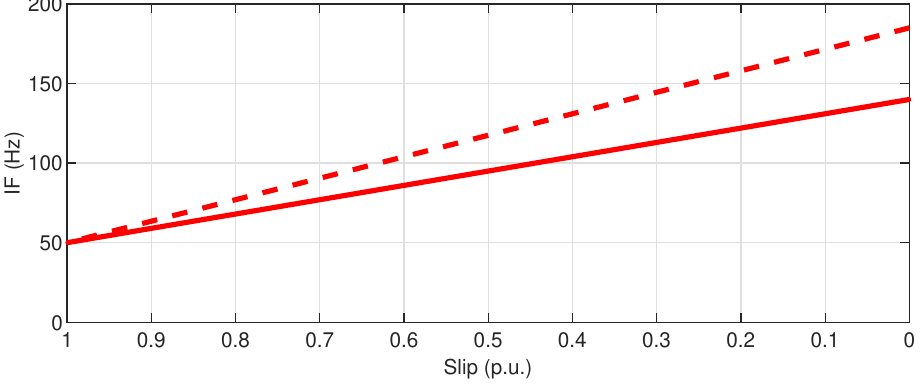
Figure 20. Theoretical signature in the slip–frequency plane of the IF of the bearing fault related harmonics, in case of a cyclic race fault in the outer race (solid line) and in the inner race (dashed